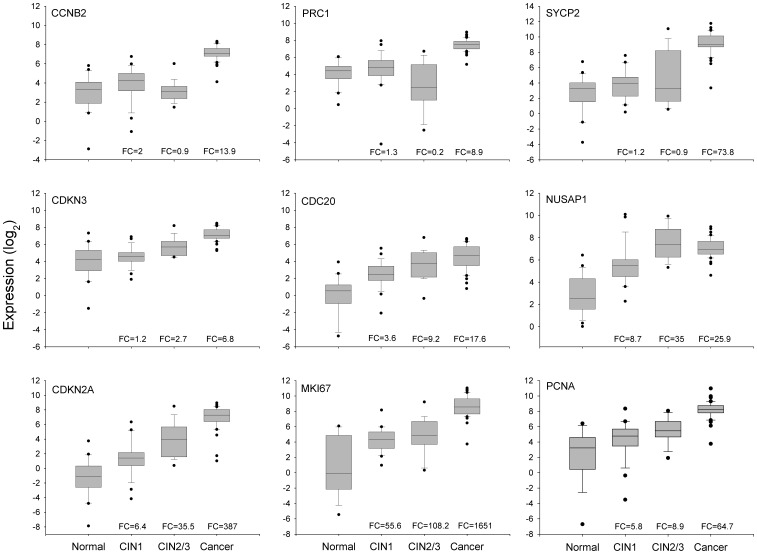
Validation of gene expression of 9 genetic markers by qRT-PCR.The intensity of gene expression, expressed in Log2 values, is shown in box plots. Expression of the 6 genes validated in this study (CCNB2, PRC1, SYCP2, CDKN3, CDC20, and NUSAP1) and the 3 well-known genes (CDKN2A, MKI67, and PCNA) associated with CC are compared among the 4 groups, including healthy cervical epitheliums (Normal, n = 25), low-grade CIN (CIN1, n = 29), high-grade CIN (CIN2/3, n = 21), and invasive CC (cancer, n = 44). The upper and lower boundaries of the boxes represent the 75th and 25th percentiles, respectively. The black line within the box represents the median value, and the whiskers represent the minimum and maximum values that lie within 1.5× the interquartile range from the end of box. Values outside this range are represented by black circles. The fold change (FC) was calculated by dividing the median of each pathological group by the median of the control group.